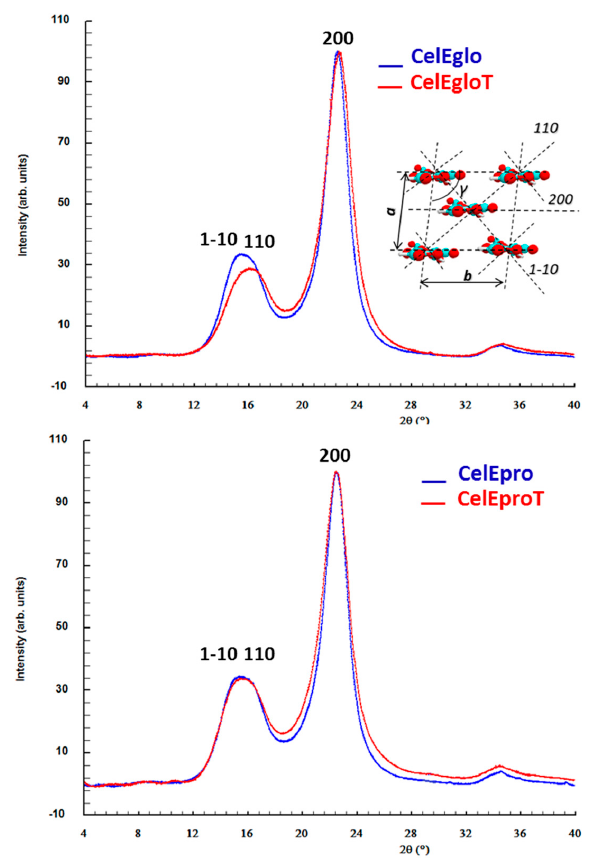
Figure 3. X-ray scattering diffractograms of cellulose isolated from two eucalypt species before (CelEglo and CelEpro) and after (CelEgloT and CelEproT) the heat treatment. The schematic representation shows the crystalline unit cell and the main lattice plans.